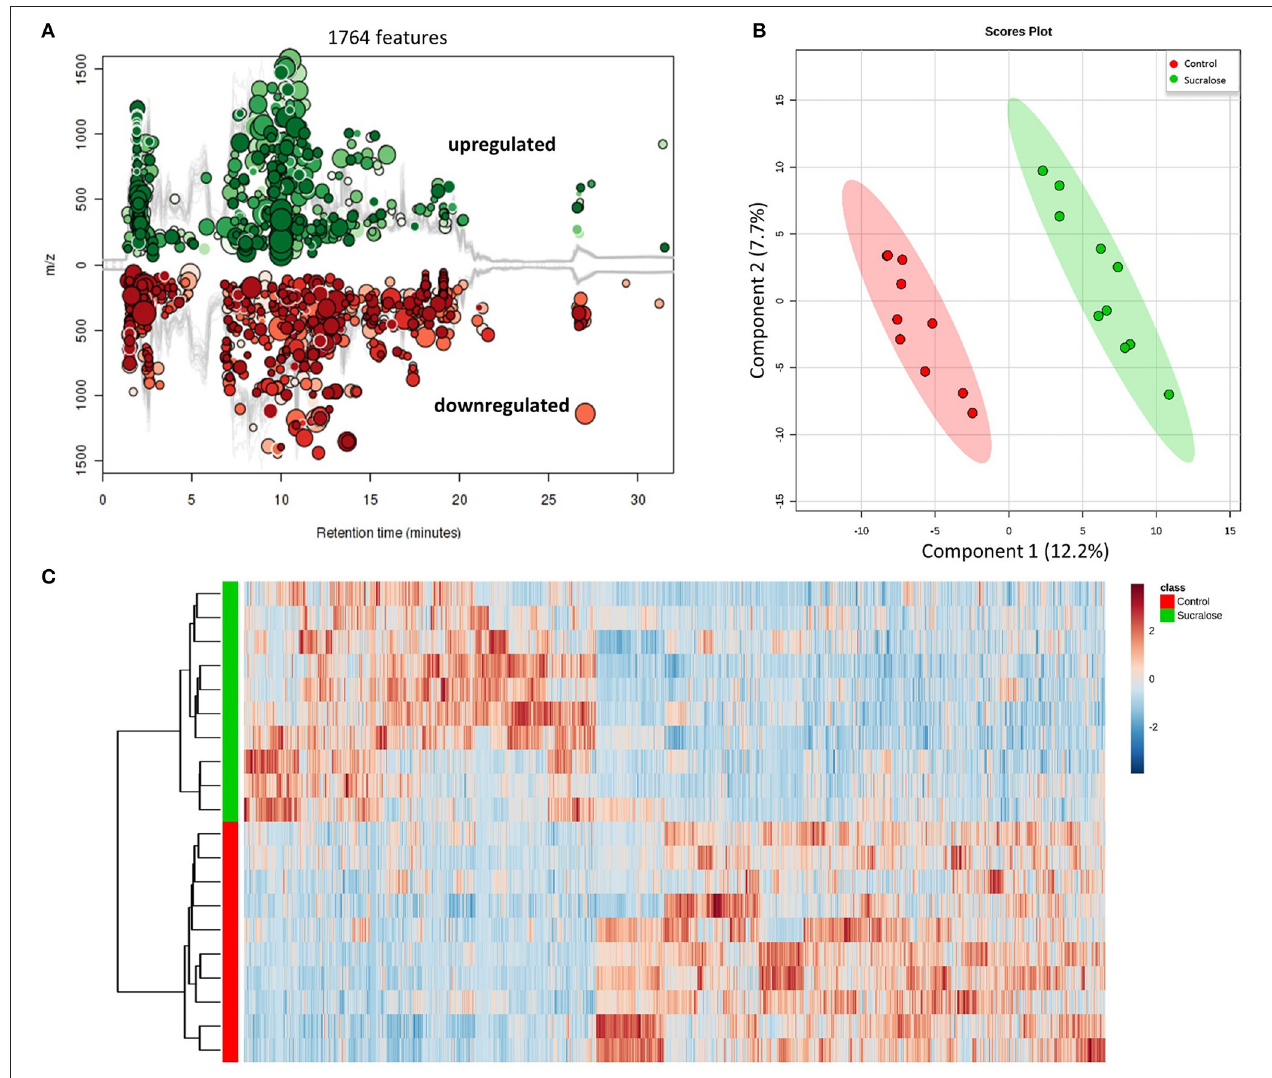
FIGURE 3 | Sucralose changed the fecal metabolome, as illustrated by the Cloud plot (A) , PLS-DA plot (B) , and heat map (C) . A total of 1,764 molecular features were significantly different ( p < 0.05 and fold change > 1.5) between sucralose-treated mice and controls.